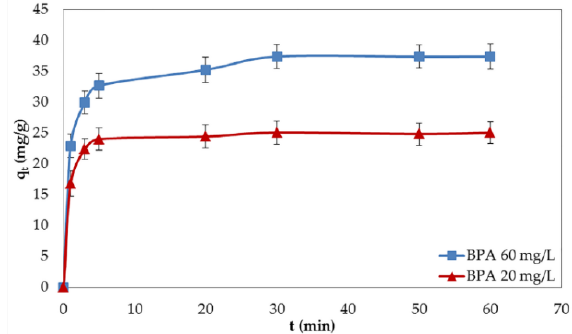
Figure 2. Effect of contact time and initial concentration on the adsorption of bisphenol A (BPA) by GO. Error bars represent the standard deviations of three replicates. q t : The amounts of BPA adsorbed on GO at time interval t (mg/g).